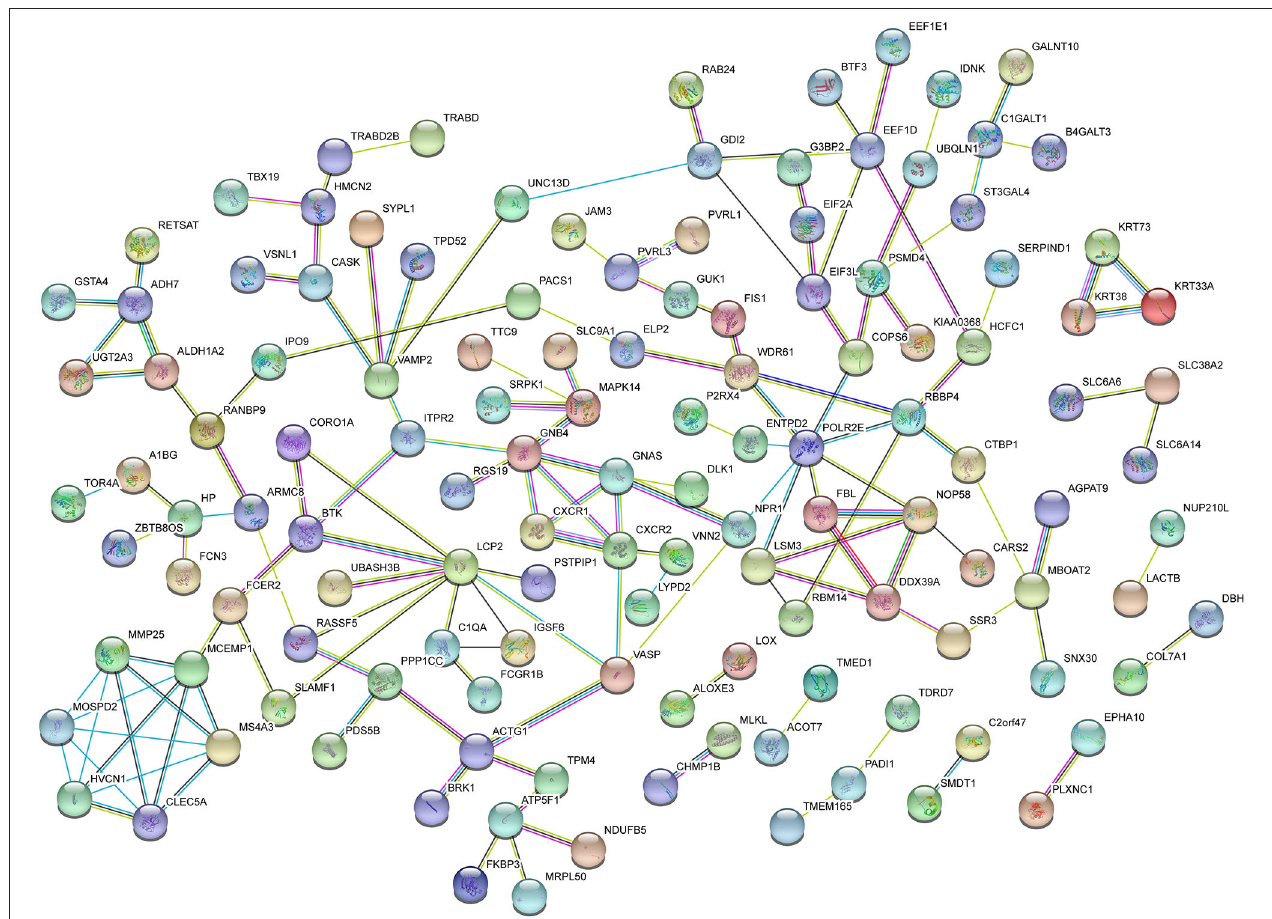
FIGURE 7 | Protein–protein interaction (PPI) network analysis of DEPs in the urine between the VD + T2DM group and the other three groups using STRING. Each node represents a protein, and each edge represents a protein–protein